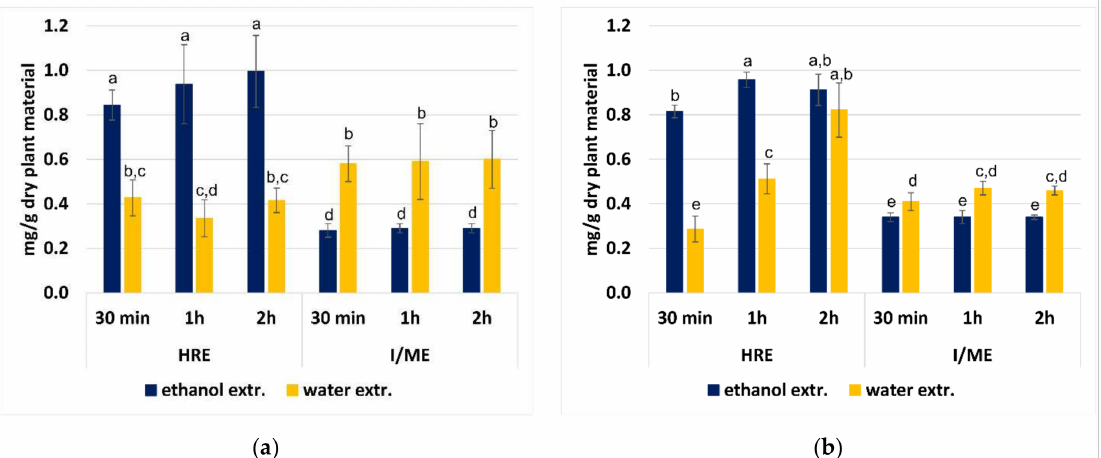
Figure 3. The content (mg/g dry plant material) of rutin (Ru) ( a ) Description of what is contained in the first panel; ( b ) Description of what is contained in the second panel. Figures should be placed in the main text near to the first time they are cited. A caption on a single line should be centered. and isoquercetin (IsoQ) in water and ethanol extracts from dried aerial parts of G. hederacea L., prepared by pouring boiling solvent followed by maceration for 30 min, 1 h or 2 h at room temperature (I/ME) and heat reflux extraction (HRE). Results are presented as the mean ± SD (standard deviation) calculated from six independent experiments. The means with the same letter are not significantly different from each other ( p > 0.05, F Welch’s ANOVA, followed by Tukey’s multiple comparison test), within the samples